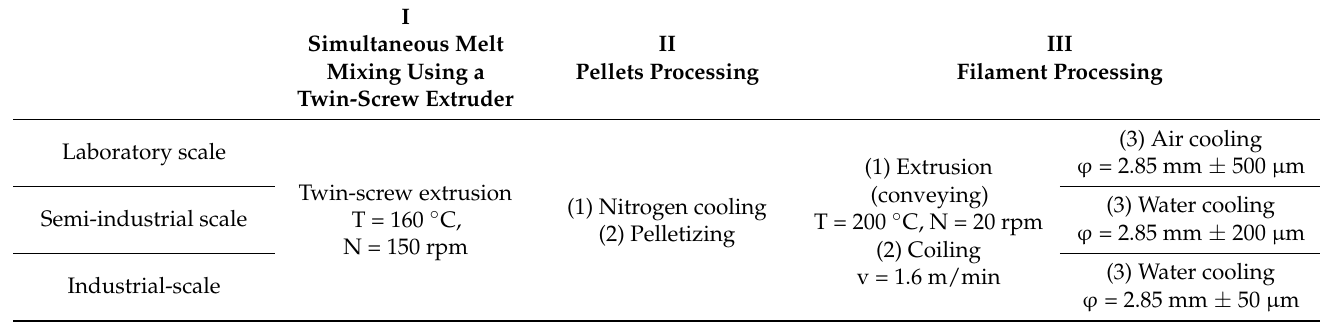
Table 1. Scheme of global filaments elaboration